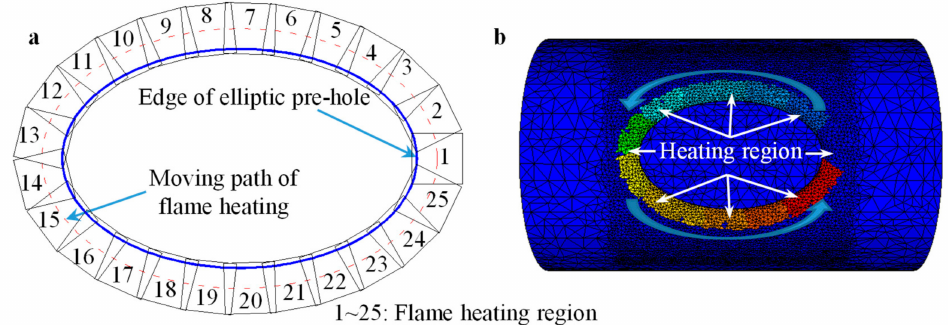
Figure 6. Local heating model: ( a ) heating path; ( b ) finite element (FE)